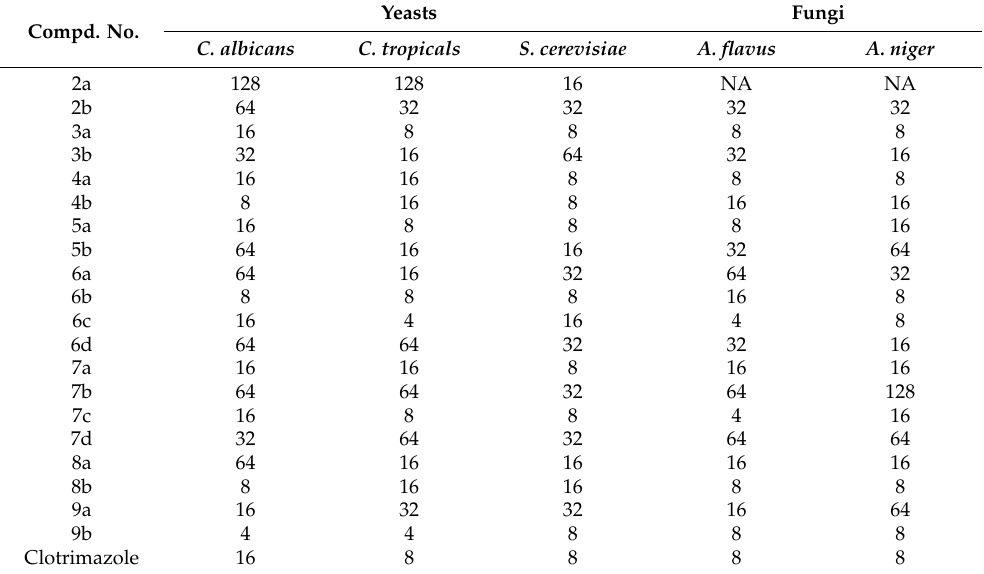
NA = No Activity (MIC > 128 µ g/mL). Table 2. In vitro antifungal activities of the synthesized compounds expressed as MICs ( µ g/mL) against the tested pathogenic yeasts and fungi. Compd.